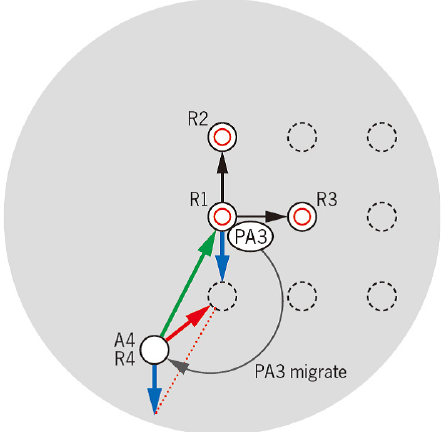
Fig. 7. A1 generates a pheromone agent and attracts A4 with its robot R4.